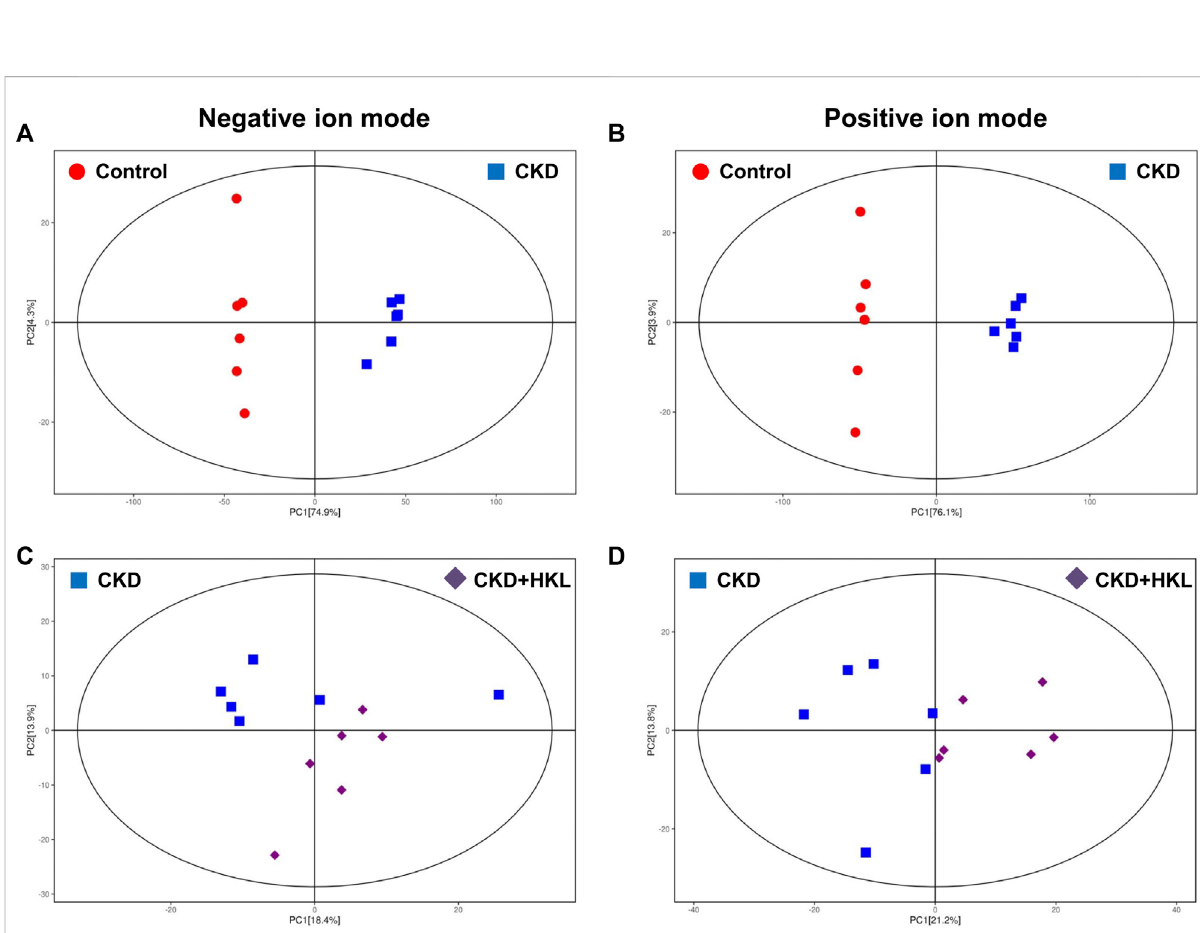
FIGURE 3 Score scatter plots of PCA models. (A) PCA score plot of the control and the CKD group in negative ion mode. (B) PCA score plot of the control andtheCKDgroupinpositiveionmode. (C) PCAscoreplotoftheCKDandtheCKD+HKLgroupinnegativeionmode. (D) PCAscoreplotoftheCKD and the CKD + HKL group in positive ion mode. The red dots represent thecontrol group, the blue squares represent the CKD group, and thepurple diamonds represent the CKD + HKL